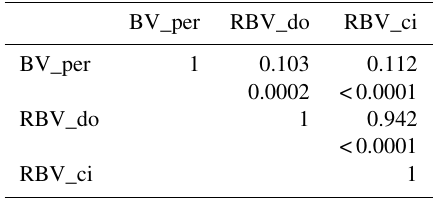
Table 6. Correlations between RBVs of reproductive traits and BV of lactation persistency.